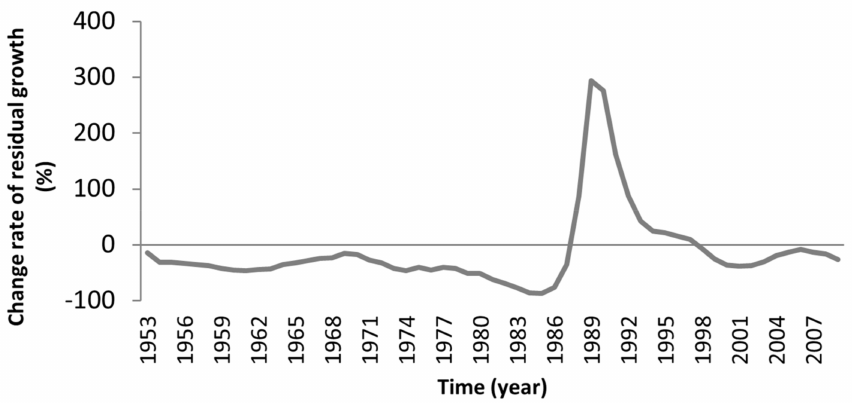
Figure 7. The variation of the growth change rate in the residual series of the ring width on the plot intensively managed.